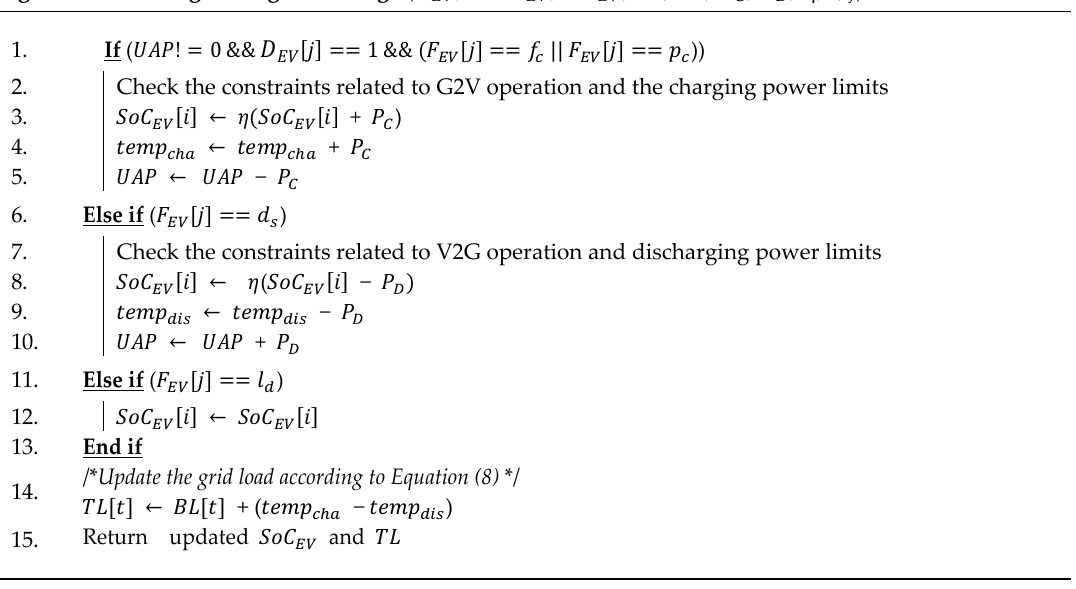
Algorithm 5: Manage_charge_discharge ( D EV , UAPF EV , SoC EV , BL , TL , P C , P D , η , i , j )